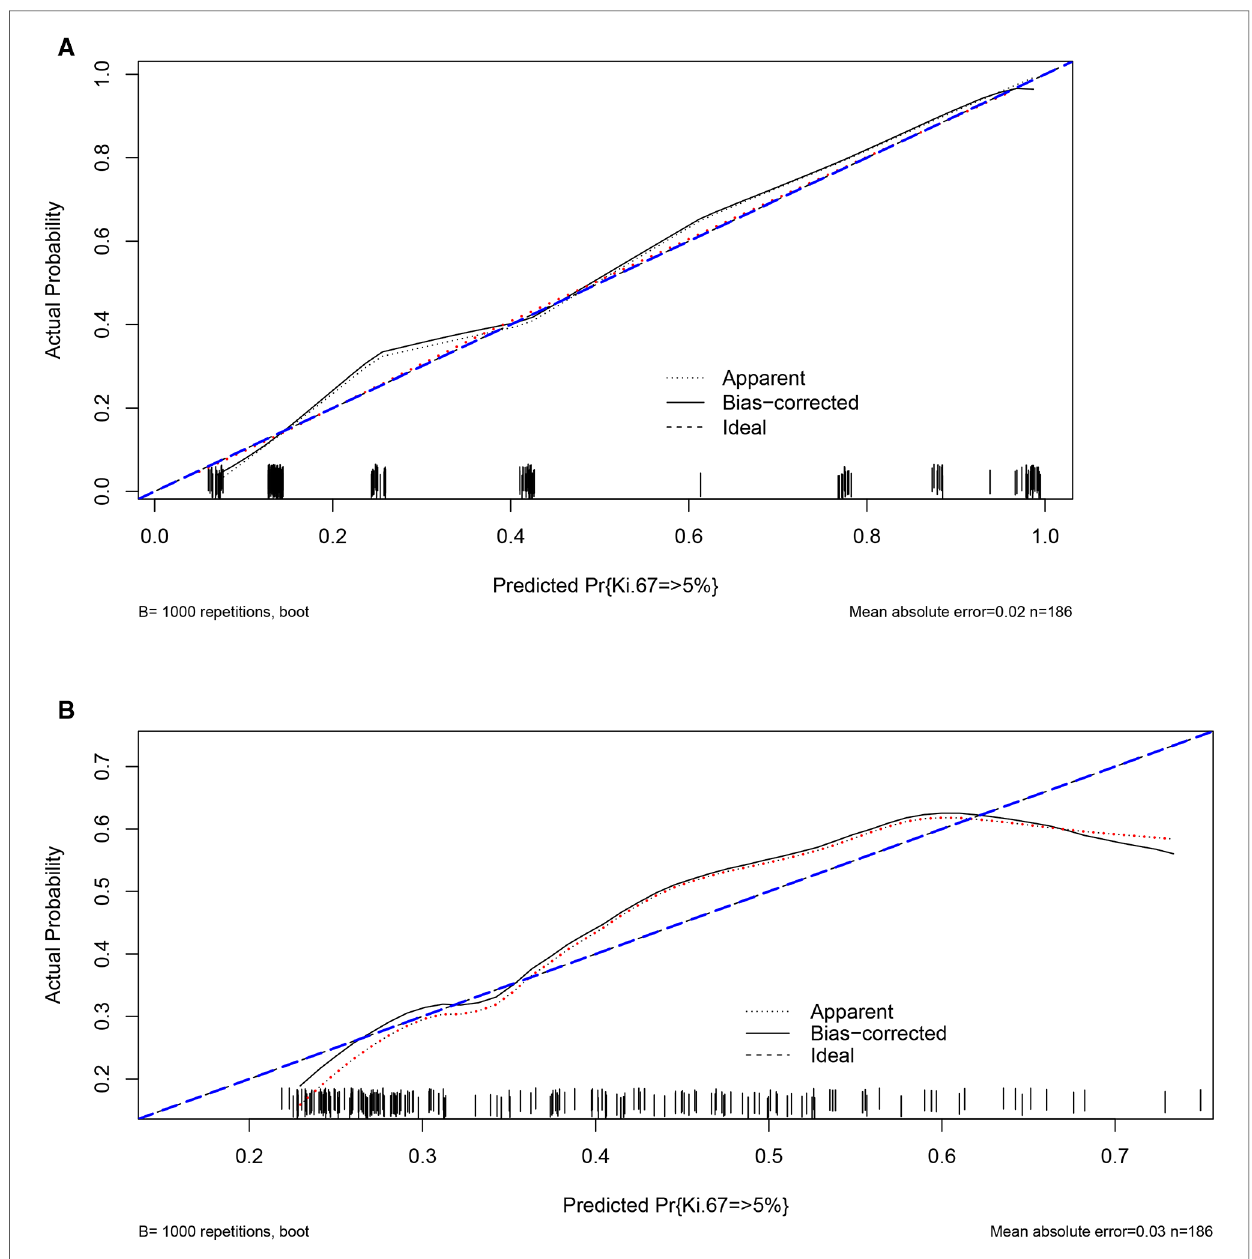
FIGURE 3 Validity of the predictive performance of the nomograms in estimating the risk of Ki-67 level >5% ( n =186). ( A ) Pathological features; ( B ) CT